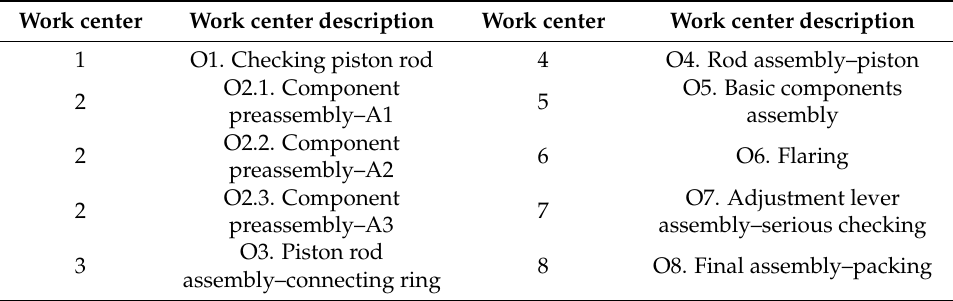
Table 3. Workcenter description.